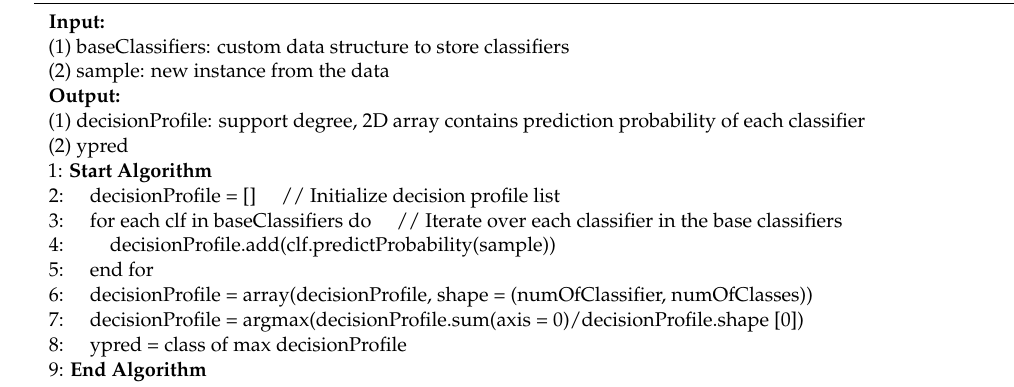
Algorithm 5. Pseudocode of global support degree for the incremental